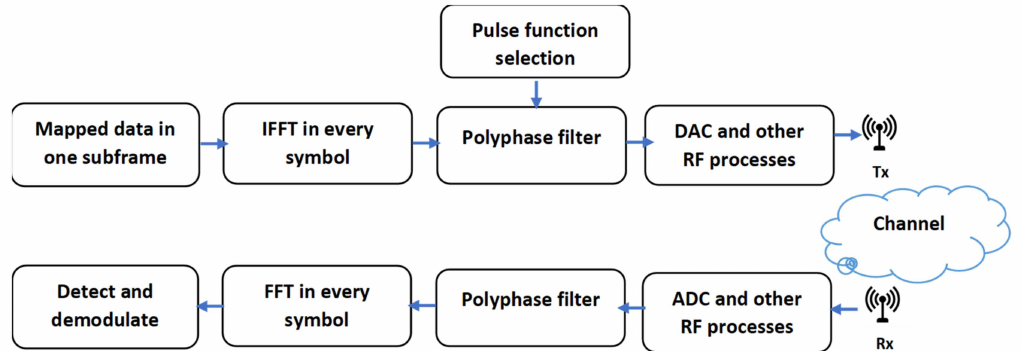
Figure 15. FB-OFDM